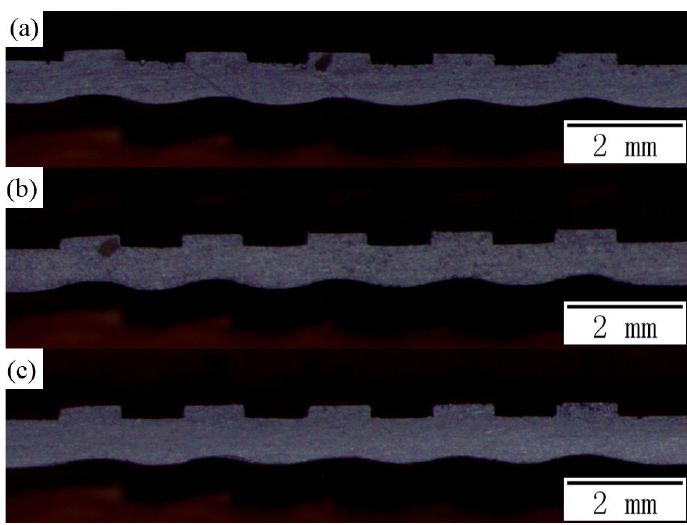
Figure 11. Cross-sectional observation of the tube deformation zone under different initial clearance conditions at 7 kV discharge voltage. ( a ) 1 mm gap; ( b ) 1.5 mm gap; ( c ) 2 mm